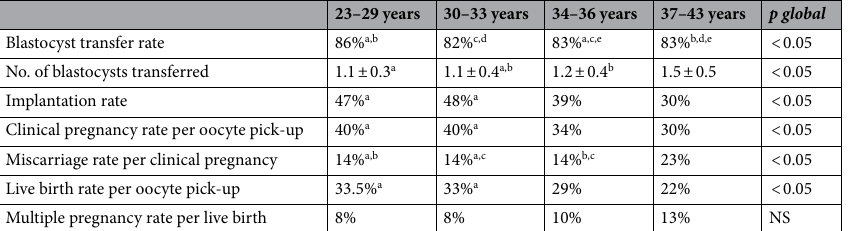
Table 2. Clinical outcomes in the age groups of women. Values with the same superscript letters are not significantly different ( p > 0.05). No number, NS